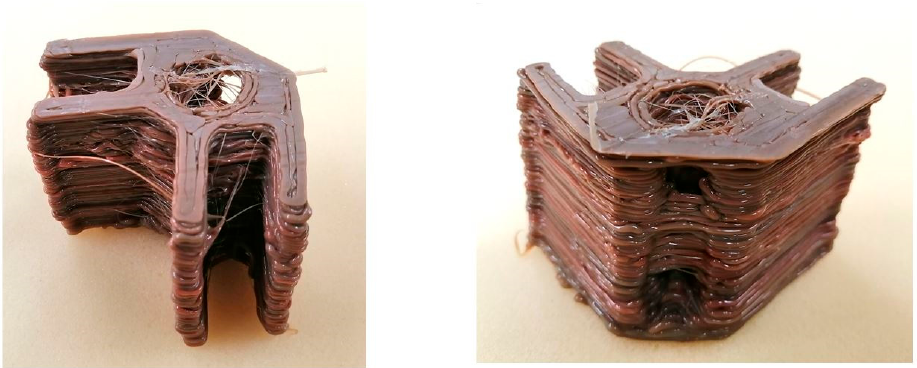
Figure 8. Example of the printing of consumer products—greenhouse corner bracket with no post- processing.